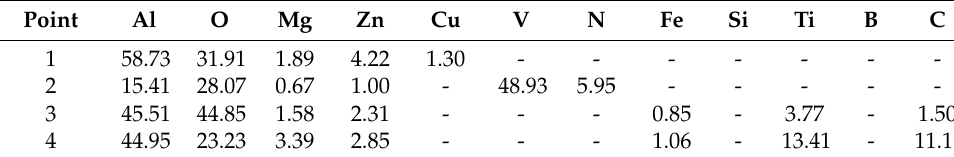
Figure 9. Elements distribution of 15 wt.% VN/7075 worn surface after wear test at 200 °C. ( a ) worn surface micromorphology; ( b ) O; ( c ) Mg; ( d ) Al; ( e ) V; ( f ) Zn. In order to further determine the type of compound on the worn surface at 200 °C, Raman spectroscopy was used to analyze the worn surface, as shown in Figure 10. The oxidation product of Al 7075 is Al 2 O 3 , the oxidation product of 15 wt.% VN/7075 compo- sites is Al 2 O 3 , VO 2 , and V 2 O 5 , and the oxidation product of 20 wt.% TiB 2 -TiC x /7075 compo- sites is Al 2 O 3 and a small amount of TiO 2 .